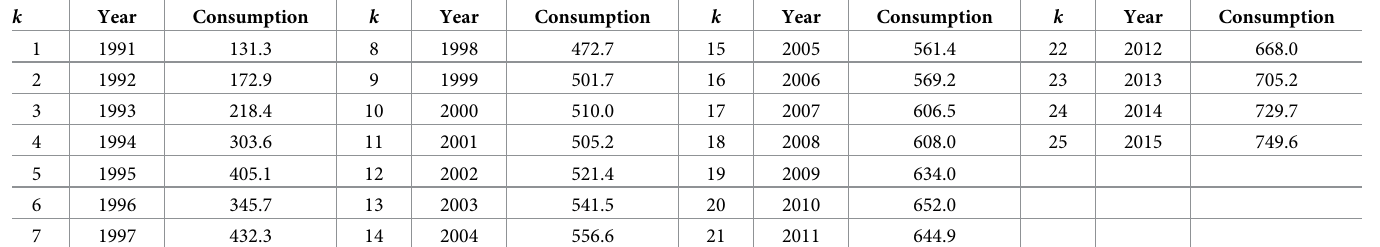
Table 3. The total beef consumption in China from 1991 to 2015. (Unit: Ten thousand tons).